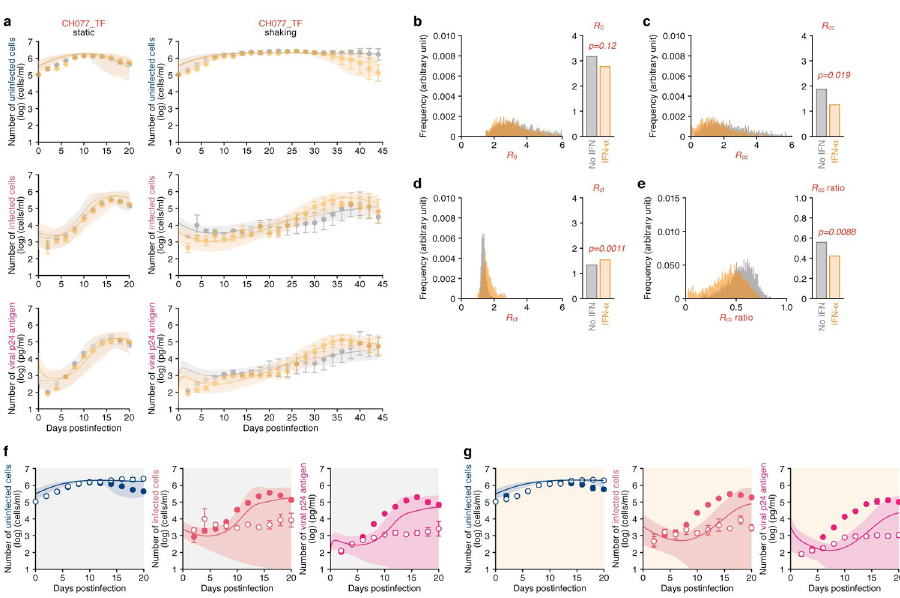
Fig 6. Dynamics of HIV-1 CH077_TF infection in static and shaking cultures without or with IFN- α . Jurkat-CCR5 cells were infected with HIV-1 strain CH077_TF at MOI 0.05 in the static and shaking culture under treated with IFN- α or untreated. a Longitudinal experimental data and the fitting of Model 1 to the data (see Methods). The time-course of experimental data for the numbers of uninfected cells (top) and infected cells (middle), and the amount of viral p24 antigen in the culture supernatant (bottom) in the static culture (left) and shaking culture (right) are shown. Gray and orange curves respectively indicate the results in the absence or presence of IFN- α treatment. The dots with error bars are the averages and SEMs of three independent experiments. The shadow regions correspond to 95% posterior predictive intervals, and the curves give the best-fit solution Model 1 to the experimental dataset. b-e The comparison of basic reproduction numbers in the absence or presence of IFN- α . (Left) The distributions of R 0 ( b ), R ( d ), computed from all the accepted parameters are shown. The contribution of cell-to-cell infection (i.e. R cc /( R cc + R cf )) is shown in panel e . (Right) The bars indicate the mean values computed by MCMC methods. Orange and gray respectively indicate the data with and without IFN- α treatment. The p values are calculated by the Brunner Munzel test. f,g Virtual simulation of cell-to-cell infection of HIV-1 strain CH077_ TF. Using our estimated parameters ( Table 3 ), the pure cell-to-cell infection is simulated in silico (solid curves). The simulated values are located between the time course of experimental data under the static conditions (closed circles) where both cell-free and cell-to-cell infection can occur and those under the shaking conditions (open circles) where only cell-free infection can occur. The shadowed regions correspond to 95% posterior predictive intervals. Panels indicate the results in the absence ( f ) or presence ( g ) of IFN- α treatment, respectively.